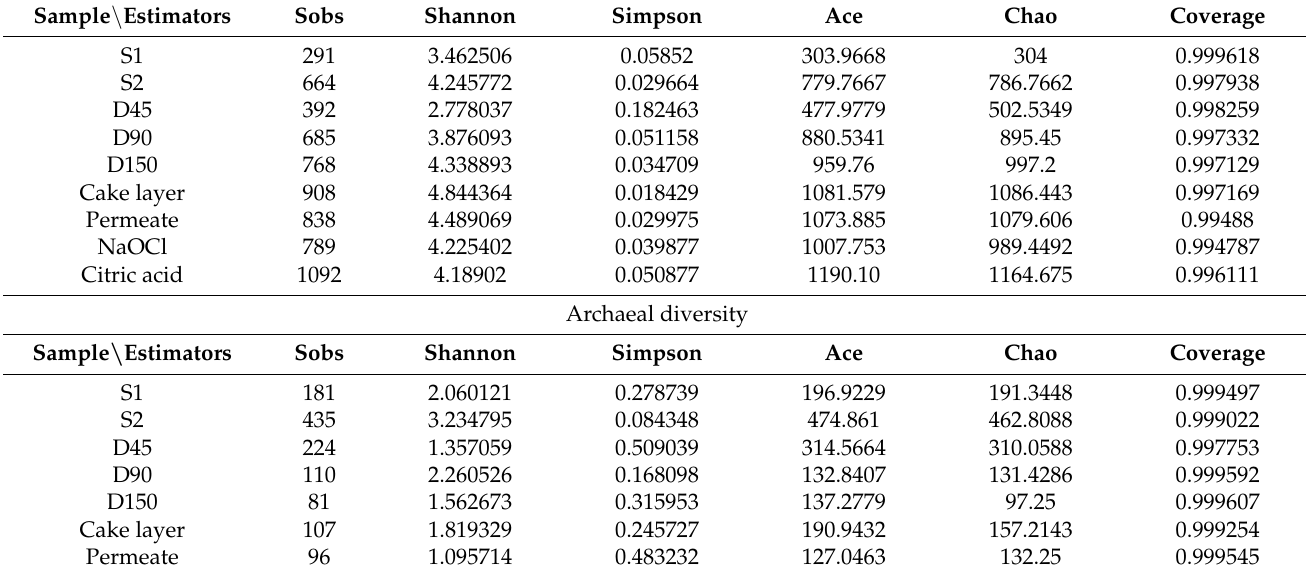
Figure 4. The community bar plot analysis of bacteria at bulk sludge, cake layer and the cleaning solutions in phylum. Table 5. The alpha diversity index for bacteria and archaeal in cleaning